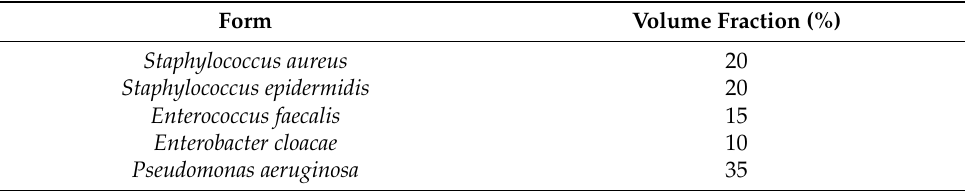
Table 3. Bacterial species used for the test